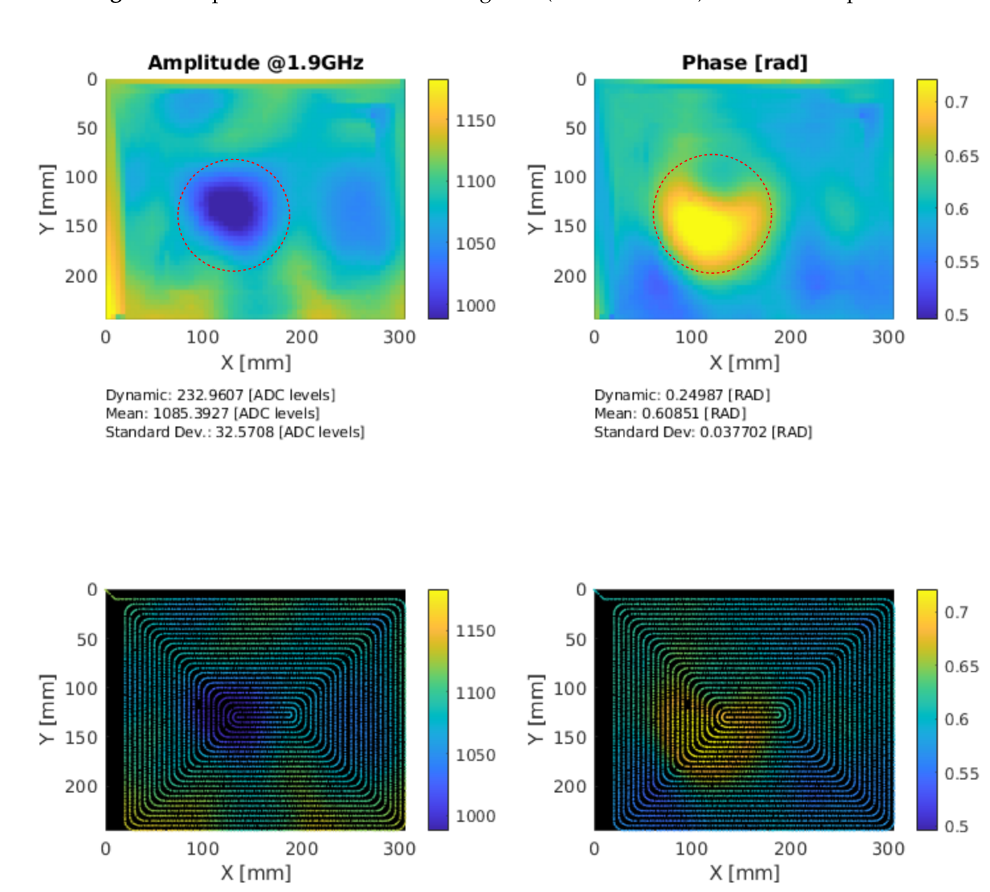
Figure 12. Acquisition of PMN4 landmine buried in the soil. On the top, amplitude and phase— referred to the phase of the transmitted signal. On the bottom, the position of the samples in the scanning plane. The path followed by the antenna is